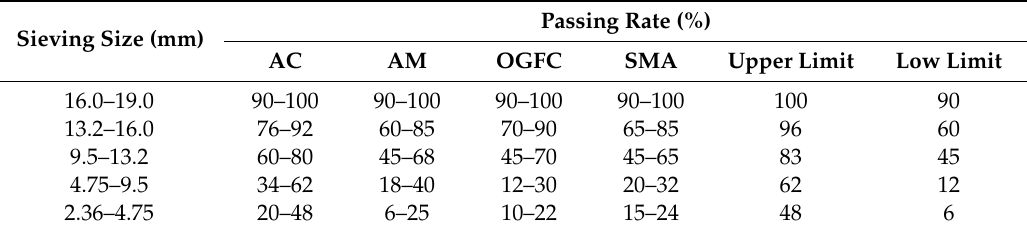
Table 2. Possible gradation scope of